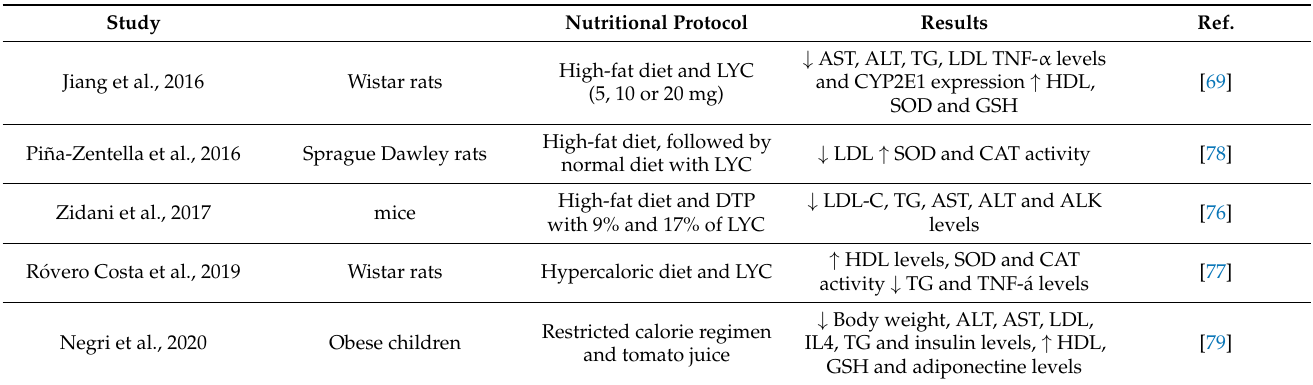
Table 1. Effects of LYC on